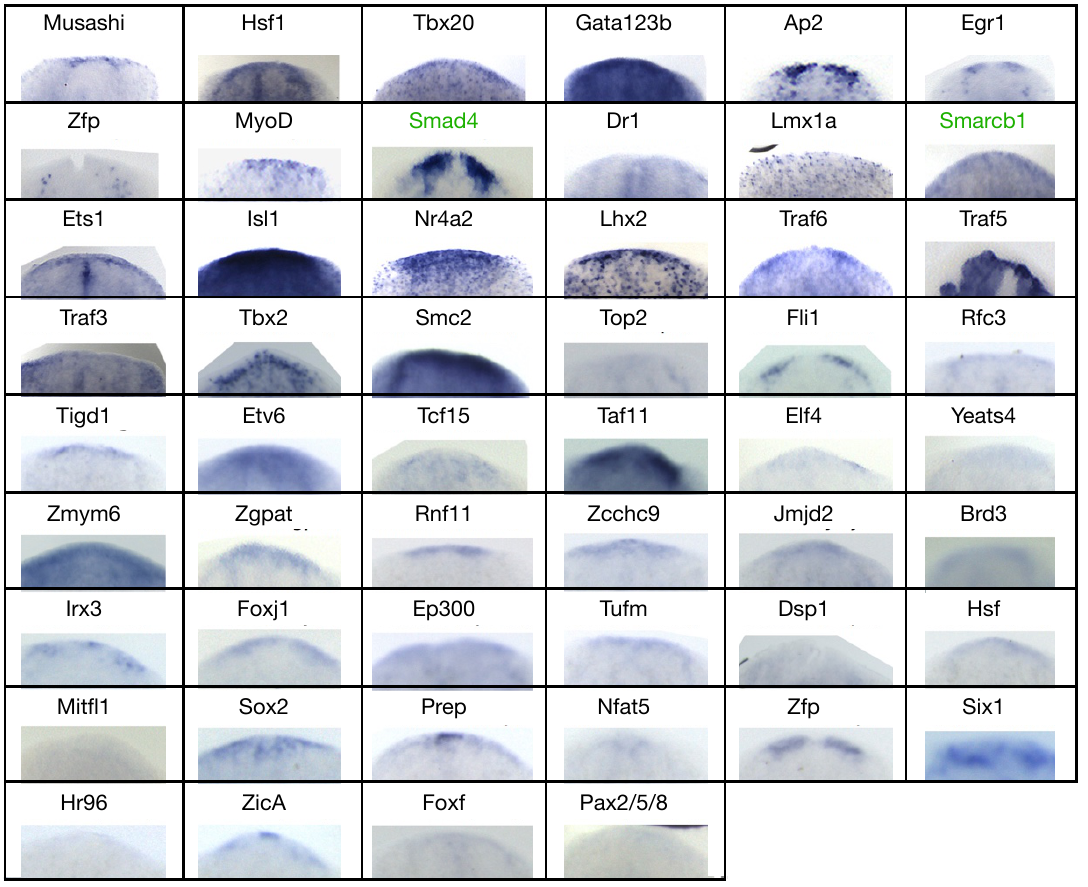
Figure 6. Expression of the shortlisted blastema transcription factors in day 3 blastema, as for WISH. Transcription factors expressed in the anterior blastema of tail fragments after 3 days of regeneration, except for Zmym6 , which is shown in the anterior blastema of a trunk fragment. In green, two genes that are not transcription factors but have some transcriptional regulation activity ( Smad4 and Smarcb1